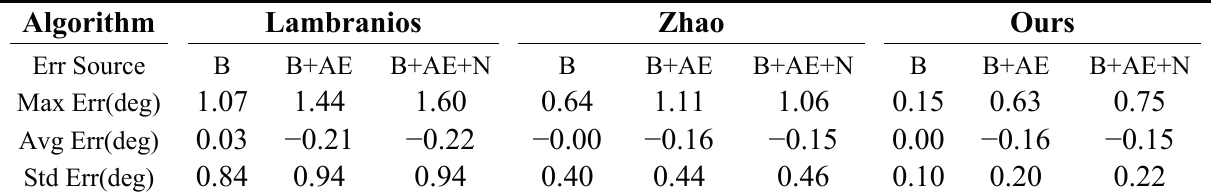
Table 1. Angle estimation error of three algorithms with different error